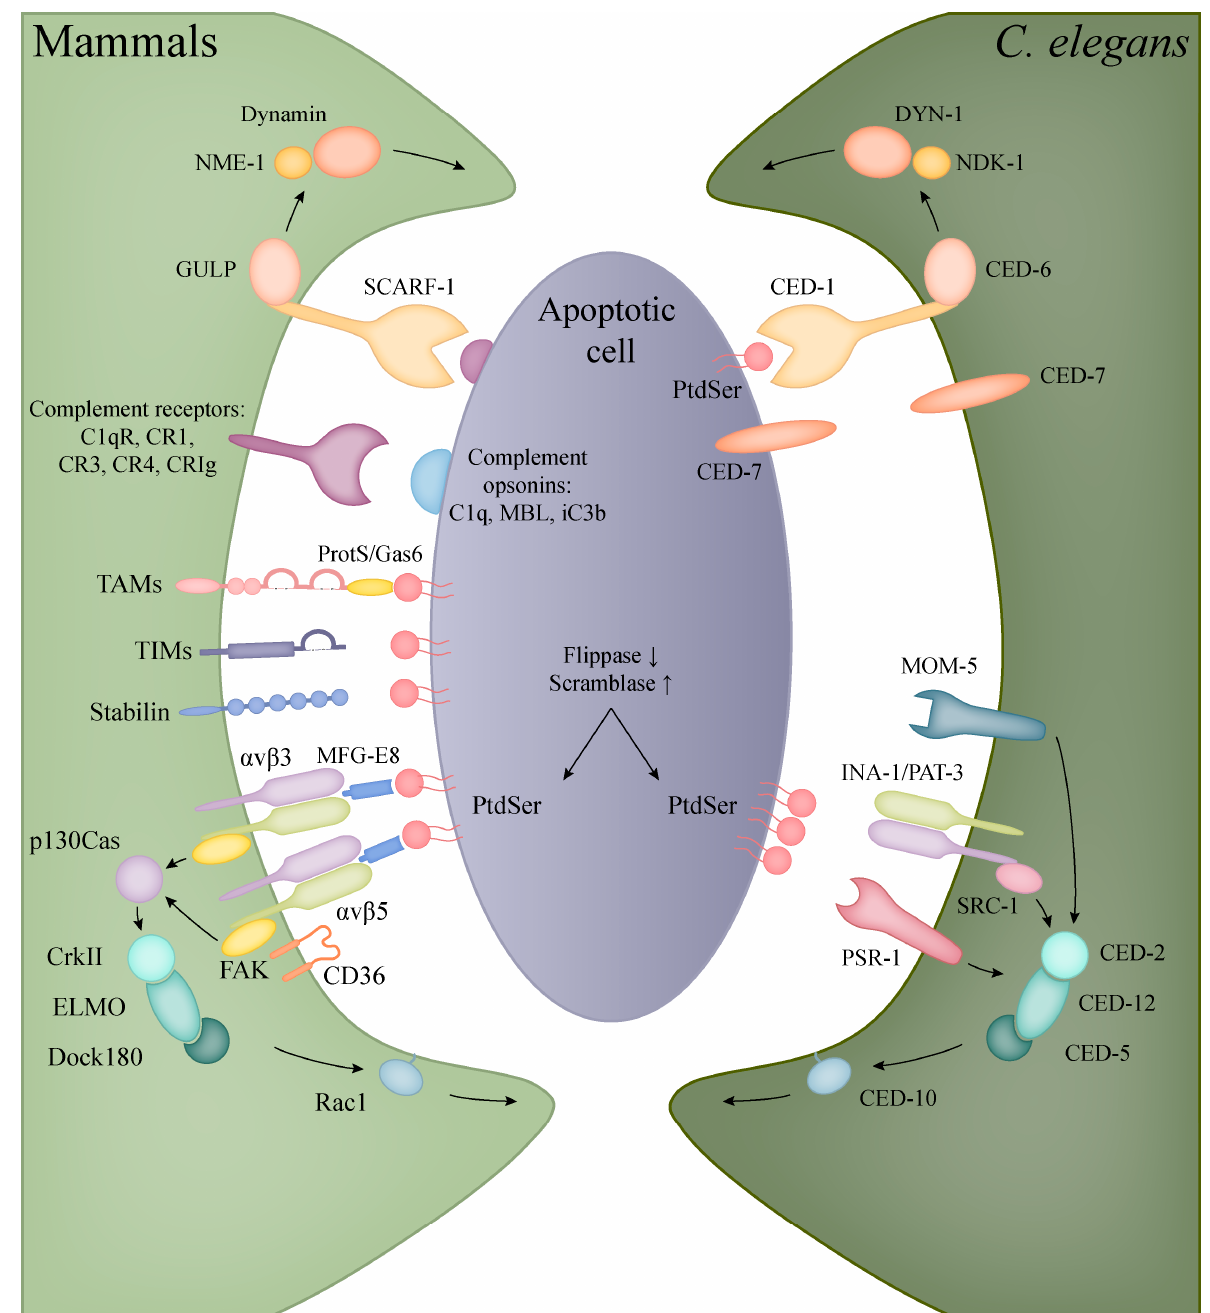
Figure 2. Recognition and engulfment of apoptotic cells in mammalian phagocytes and C. elegans. The evolutionarily conserved CED-1/CED-6/DYN-1 (corresponding to human SCARF-1/GULP/Dynamin) and CED-2/CED-5/CED-12/CED-10 (in human: CrkII/Dock180/ELMO/Rac1) pathways are present in both C. elegans and mammals with the same functions in the clearance of apoptotic cells (orthologous molecules are indicated with the same colours). In mammals, however, a higher diversity can be observed in the recognition of apoptotic bodies, including the families of TIM and TAM proteins, complement and scavenger receptors.